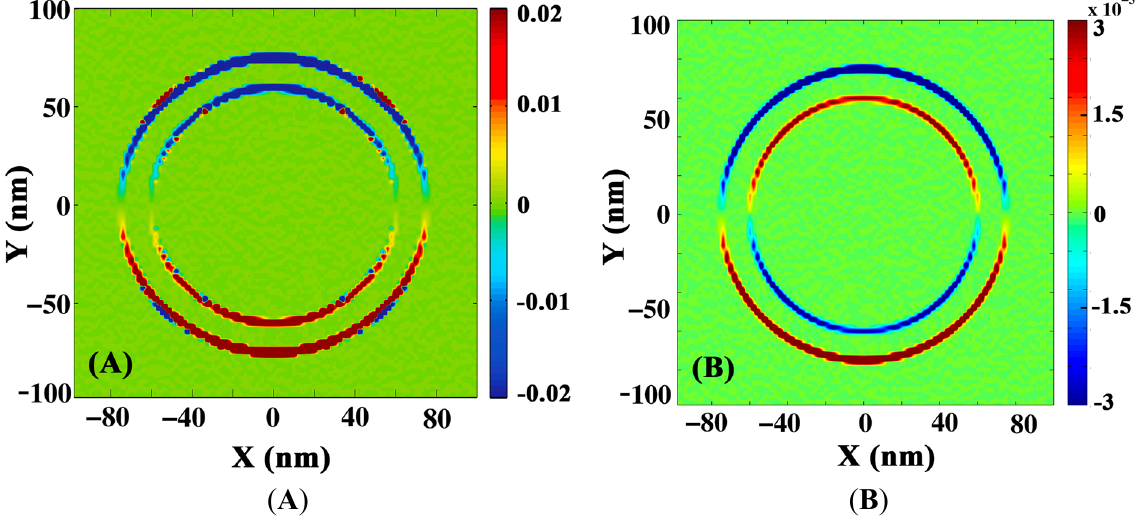
Figure 10. Simulated 2D distribution of charge density for ( A ) bonding and ( B ) antibonding hybridized plasmon frequency.